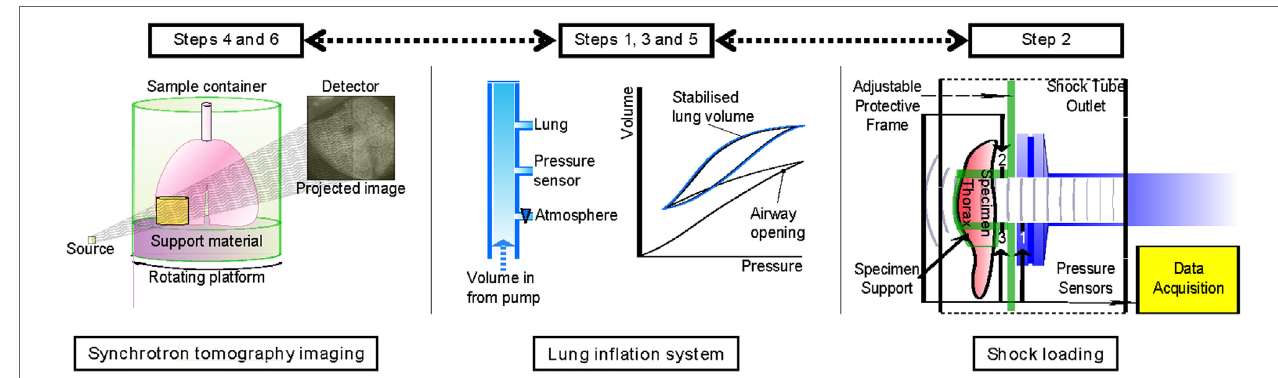
FigUre 1 | Experimental summary indicating the order of each experimental step: ventilation, blast loading, and tomographic imaging.